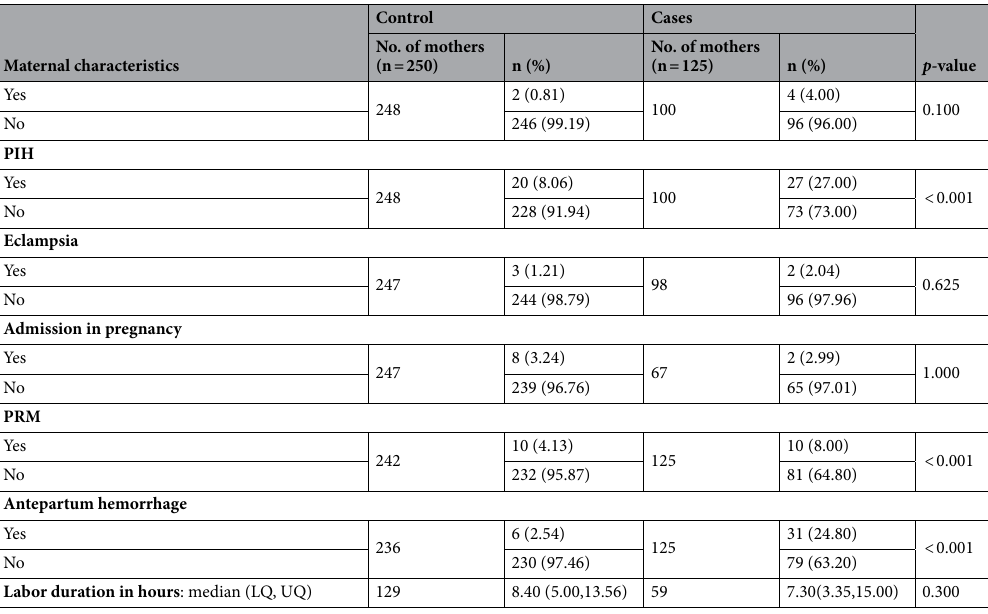
Table 1. Bivariate analysis of maternal factors associated with intrapartum stillbirth in the Greater Accra Region in 2016. PIH Pregnancy Induced Hypertension, PRM Premature Rapture of Membrane, SD Standard Deviation, UQ Upper quartile, LQ Lower quartile, (%) represent column percentage; n: Total number of cases and controls that were used in the estimation of the test statistics.